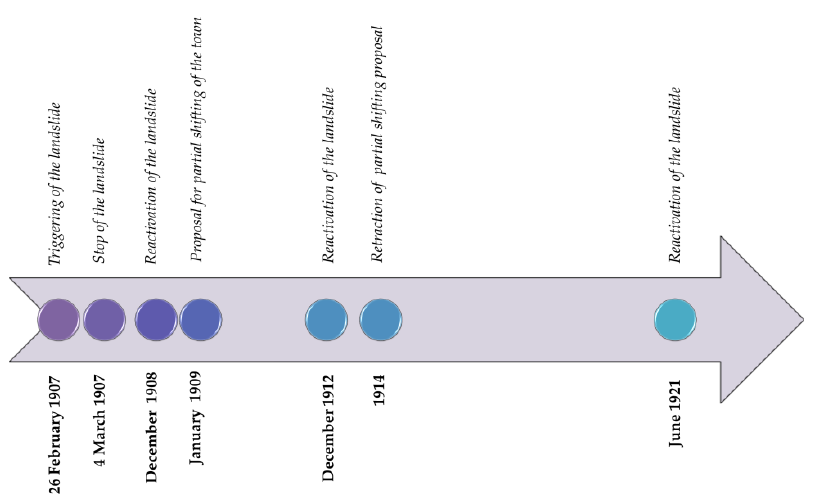
Figure 12. Timeline of the main events of the Servigliano landslide as inferred from the scrutiny of archive sources.